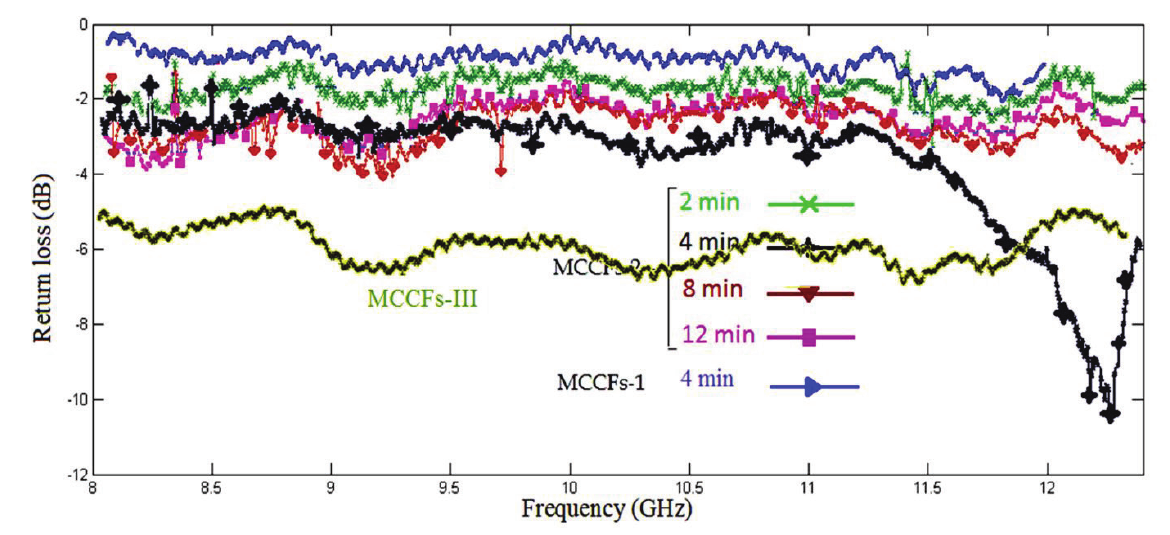
Fig. 5. Reflectivity curves of samples coated in 2-12 min and